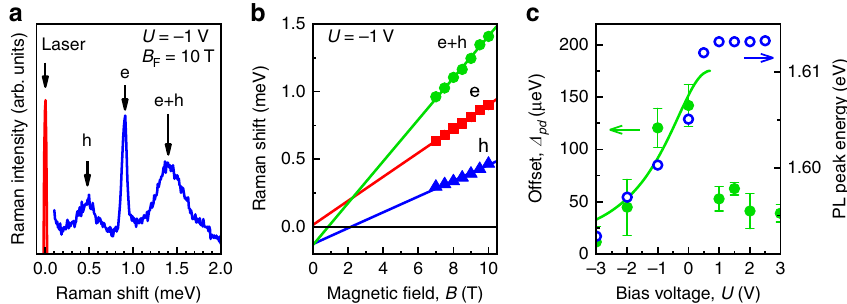
Fig. 4 Spin- fl ip Raman scattering (SFRS). a SFRS signal under resonant excitation of the A 0 X complex at a magnetic fi eld B F = 10 T tilted by 20° with respect to the sample growth direction. Line h corresponds to a single acceptor hole spin- fl ip process, e + h is a double spin- fl ip process, and e is a spin fl ip of a conduction band electron. b Dependence of the Stokes shifts of the three lines on the magnetic fi eld. c Dependence of the exchange constant Δ pd on the applied voltage U for the hole bound to an acceptor (green solid circles) and the corresponding dependence of the energy of the PL peak ħ ω max ( U ) (blue open circles). The solid curve is calculated from Eq. (8) with A = 175 μ eV, U 0 = 0.7 V, and U 1 = 1.8 V. Error bars represent standard